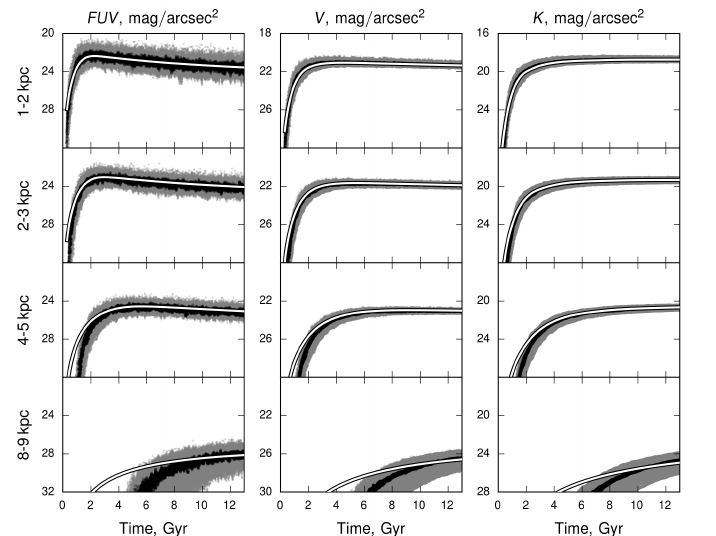
Fig. 7. The same as in Fig. 3, but for the surface brightness in the GALEX FUV , V and K passbands.